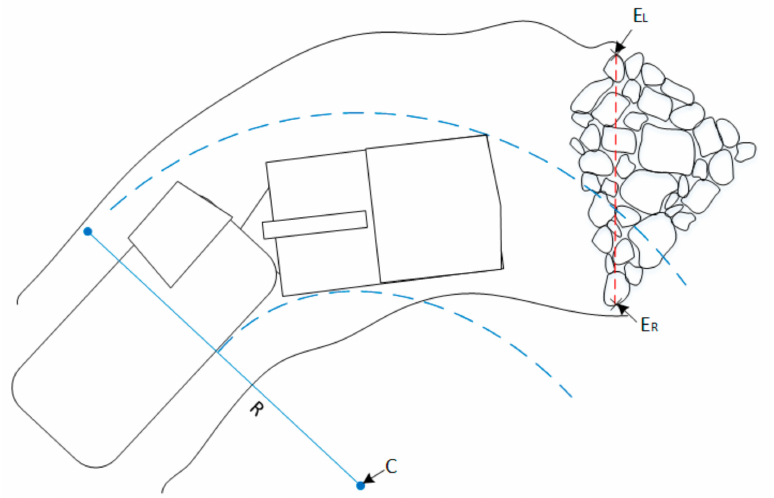
Figure 12. Intersection of the predicted trajectory with the detected pile limits. Left and right pile limit points denoted as E L and E R , respectively (with the face of the pile between them in a red segmented line). LHD’s left side circular trajectory center and curvature radius denoted with C and R, respectively. In a blue dotted line both sides of the predicted LHD’s trajectory is